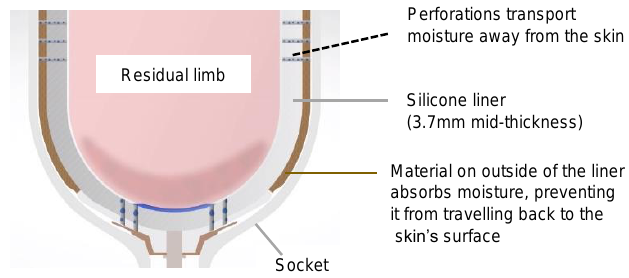
Figure 1: A cross-sectional image of the Silcare Breathe liner (Blatchford). I,II Moisture is transported away from the skin through perforations located along the sides and at the distal end of the liner. These perforations allow moisture produced by the body to be transported to the outside of the liner, so that it doesn’t remain on the surface of the skin. Moisture is then readily absorbed by the fabric on the outside of the liner, rather than by the silicone, so that it does not migrate back towards the skin and the liner can be more easily